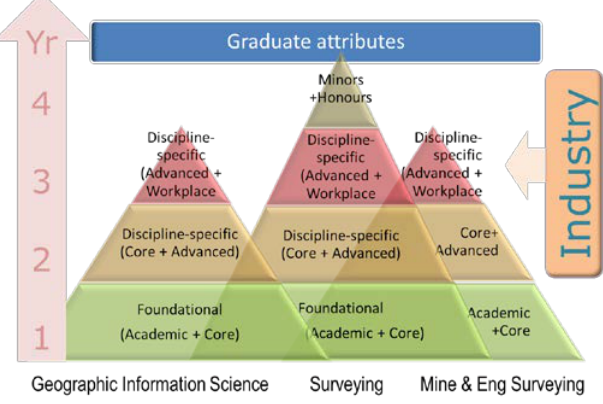
Figure 4: Application of the GIScience curriculum framework to different spatial sciences education